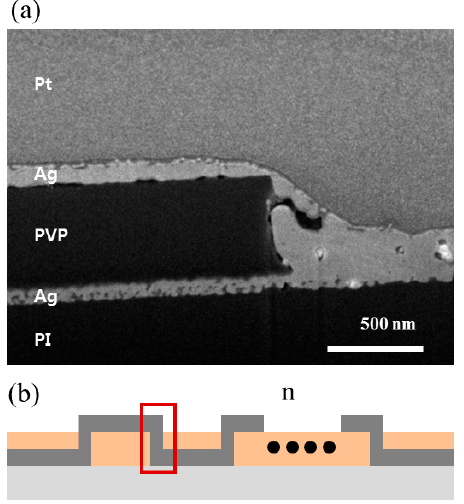
Table 1. The measured resistances (mean ± standard deviation) according to the number of interconnections.